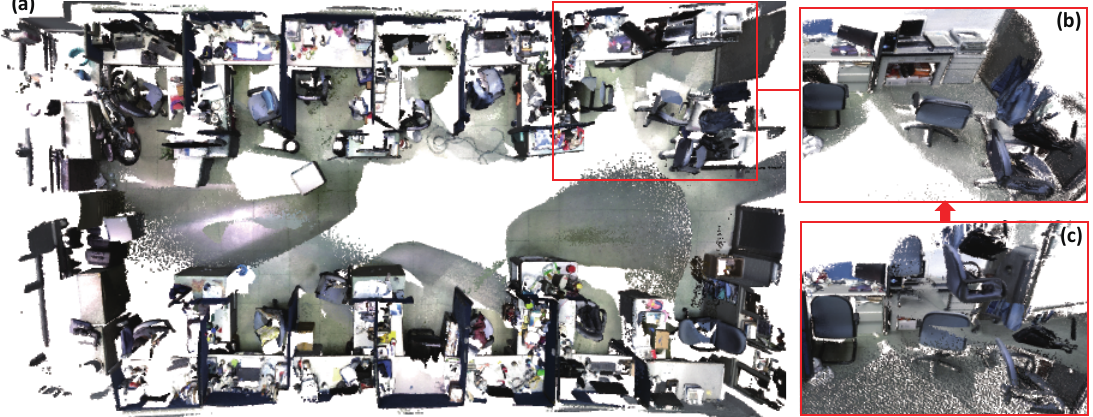
Figure A1. Reconstruction of an office room. ( a ) shows the produced 3D model. ( c ) gives the details of the surface around the loop closure before model correction. ( b ) is the surface after the